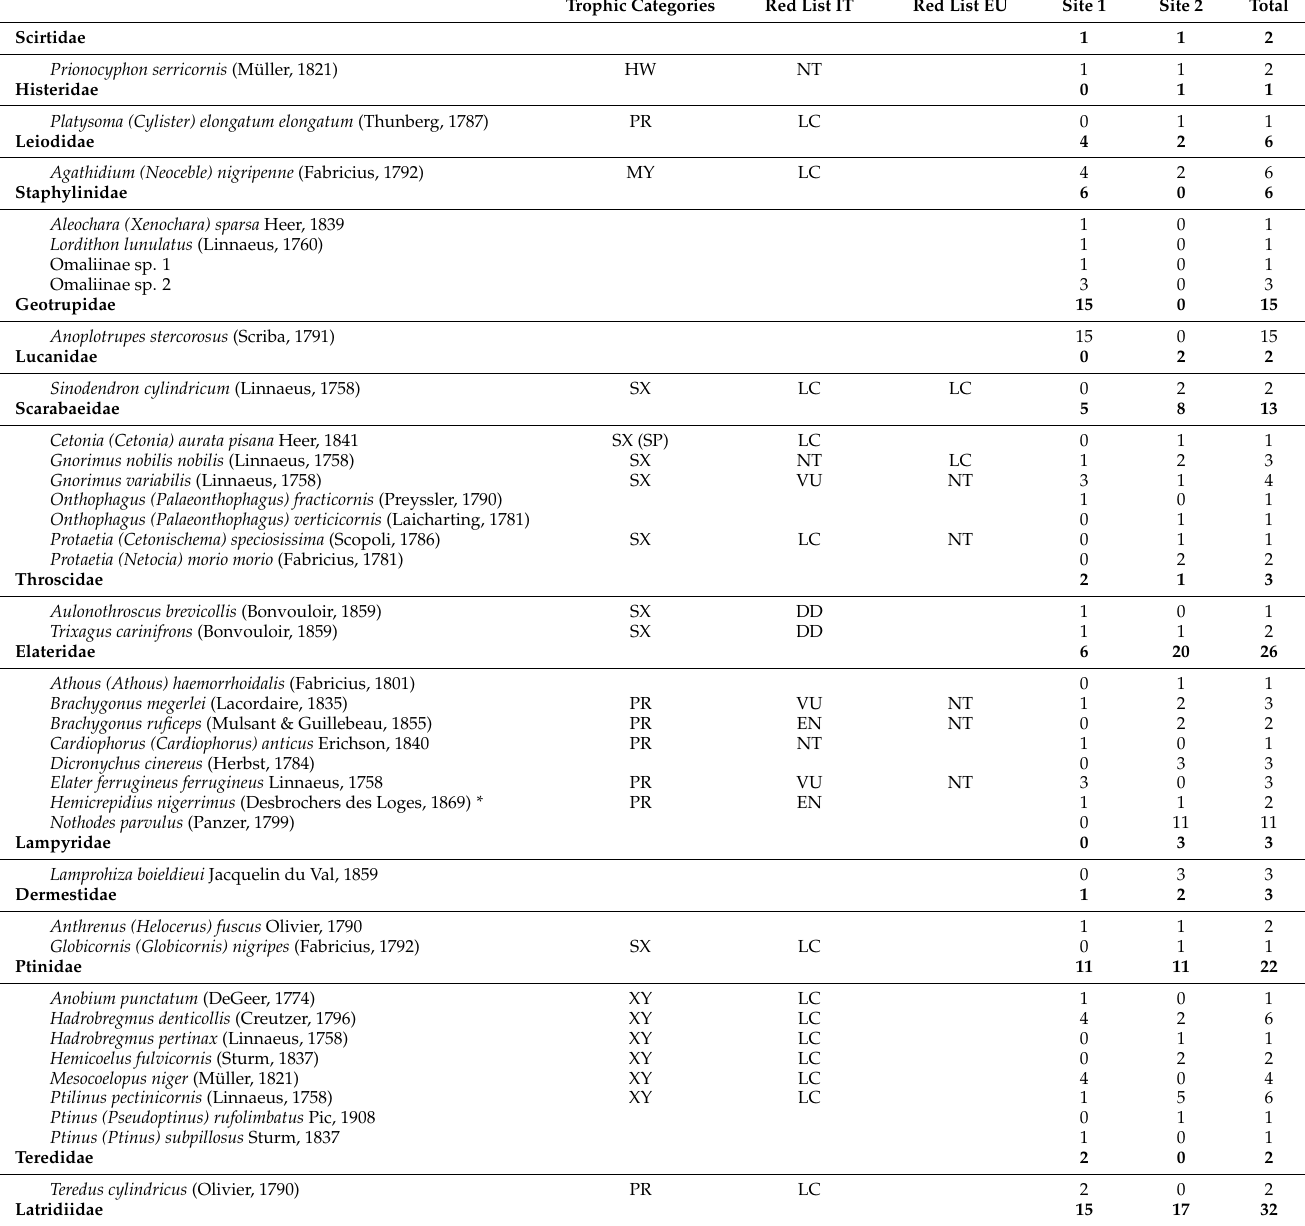
debris (CWD) was surveyed, measuring their length/height and diameter, and recording the species. The volume of standing dead trees (SDT) was calculated by double-entry volume equations [45], while the volume of logs and stumps was calculated through the cone trunk formula. The decay stage of CWD was assigned using the five-class scale used by [46]. Table 1. Species checklist with the abundance of each species in Site 1, Site 2, and total. Trophic and IUCN categories of risk are reported for saproxylic beetles according to [21]. Trophic categories are CO commensal of SX/XY or of other saproxylic insects, HW saprophagous in small water pools inside hollow trees, MB mycetophagous, MY mycophagous, PR predator, SF feeding on fermented sap, SP saprophytophagous on rotting vegetal matter, SX saproxylophagous, and XY xylophagous. Risk categories (IUCN) are LC least concern, NT near threatened, VU vulnerable, EN endangered, NA not applicable, and DD data deficient. Species names marked with an asterisk [*] follow the nomenclature of